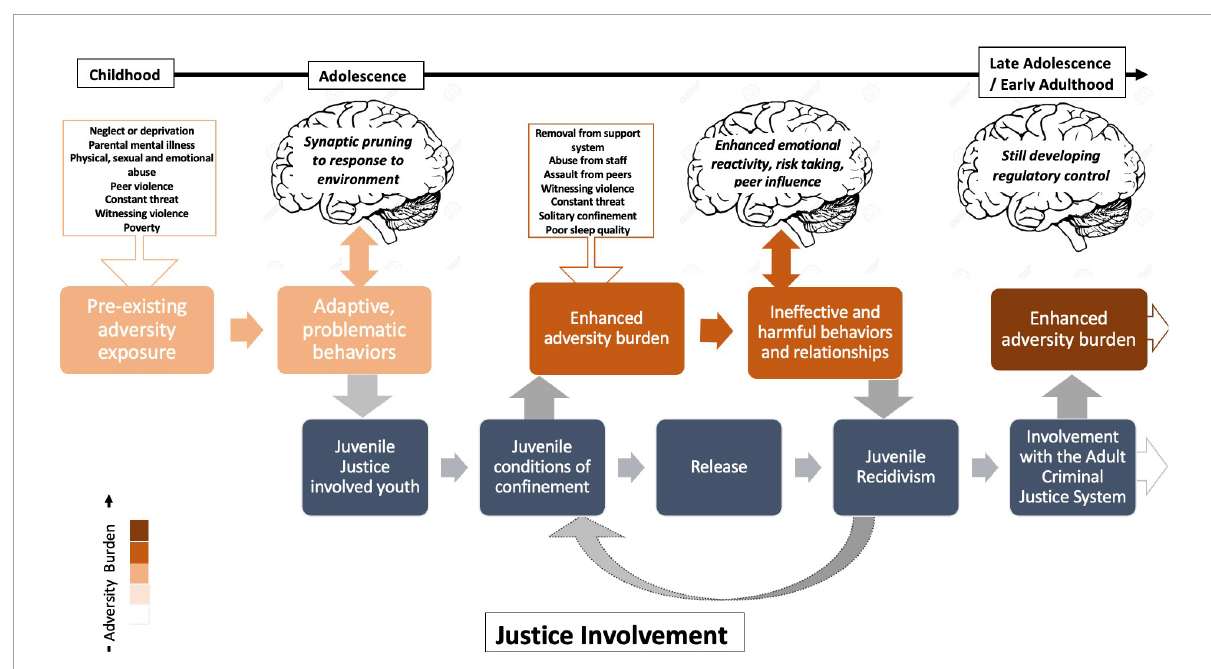
FIGURE1 Conceptual representation of youth adversity exacerbation in the juvenile justice system